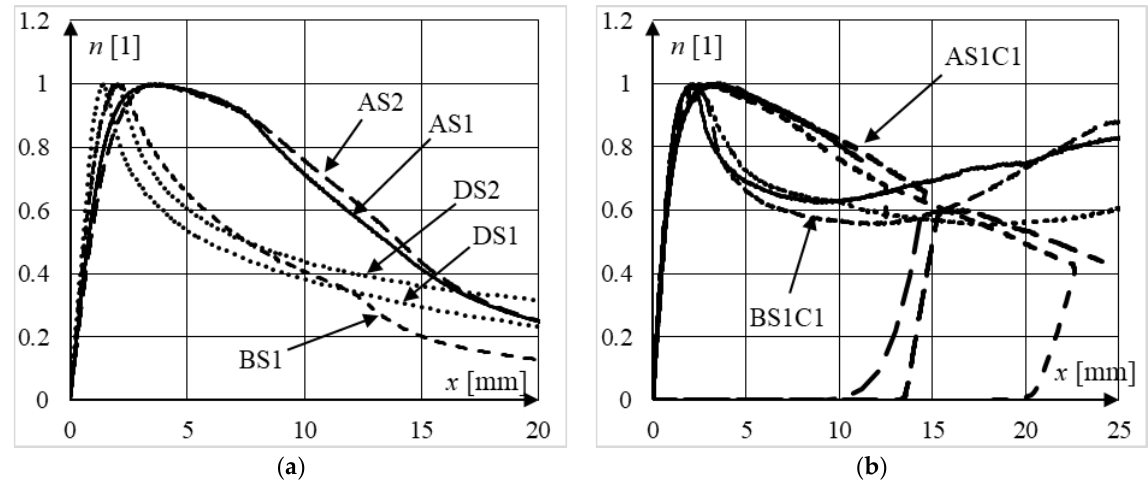
Figure 14. Comparison of normalized equilibrium paths of: ( a ) steel columns from all series; ( b ) slender composite columns from series AS1C1 and BS1C1.